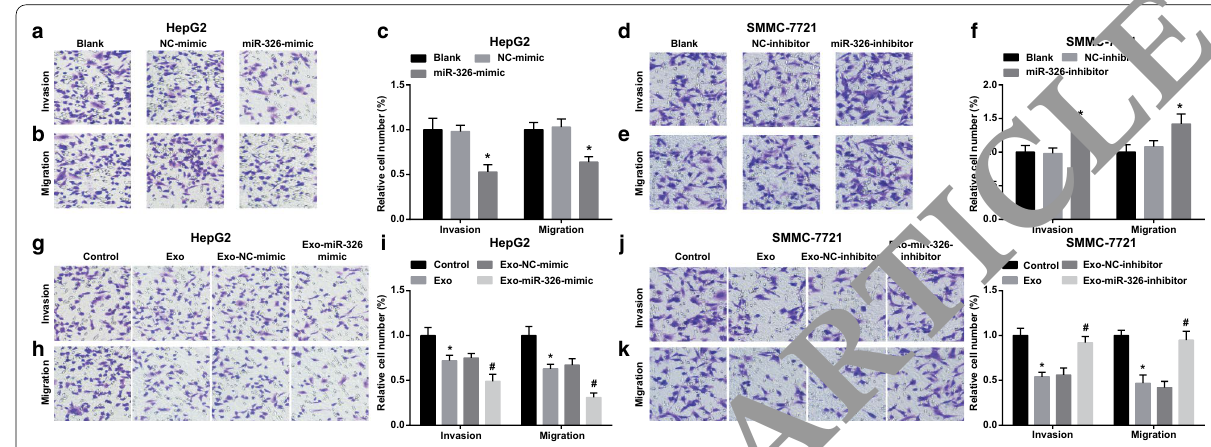
Fig. 4 M1 macrophage exosomal miR‑326 inhibits migration and invasion of HCC cells. a Transwell assay detected the effect of transfection of miR‑326 mimic on the invasion of HepG2 cells. b Transwell assay detected the effect of transfection of miR‑326 mimic the migration of HepG2 cells. c The number of invasion and migration of HepG2 cells. d Transwell assay detected the effect of transfection of miR‑326 inhibitor on the invasion of SMMC‑7721 cells. e Transwell assay detected the effect of transfection of miR‑326 inhibitor on the migration of SMMC‑7721 cells. f The number of invasion and migration of SMMC‑7721 cells. g Transwell assay detected the effect of co‑culture with miR‑326 mimic‑transfected M1 macrophage‑derived exosomes on the invasion of HepG2 cells. h Transwell assay detected the effect of co‑culture with miR‑326 mimic‑transfected M1 macrophage‑derived exosomes on the migration of HepG2 cells. i The number of invasion and migration of HepG2 cells co‑cultured with M1 macrophage‑derived exosomes. j Transwell assay detected the effect of co‑culture with miR‑326 inhibitor‑transfected M1 macrophage‑derived exosomes on the invasion of SMMC‑7721 cells. k Transwell assay detected the effect of co‑culture with miR‑326 inhibitor‑transfected M1 macrophage‑derived exosomes on the migration of SMMC‑7721 cells. l The number of invasion and migration of SMMC‑7721 cells co‑cultured with M1 macrophage‑derived exosomes. In panel c, * P < 0.05 versus the NC‑mimic group; In panel f, * P < 0.05 versus the NC‑inhibitor group; In panel i, * P < 0.05 versus the control group, # P < 0.05 versus the Exo‑NC‑mimic group; In panel l, * P < 0.05 versus the control group, # P < 0.05 versus the Exo‑NC‑inhibitor group. Measurement data were depicted as mean standard deviation ( N 3), comparisons among multiple groups were ± = conducted by one‑way analysis of